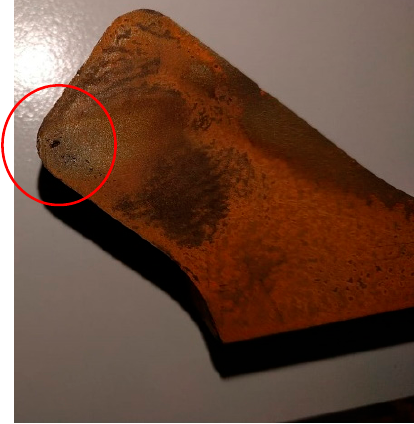
Figure 8. ( a ) Obtained components in Trials 1, 2 and 3, respectively, (from left to right). Detail of the last part filling (fingers) in ( b ) Trial 2 and ( c ) Trial 3.